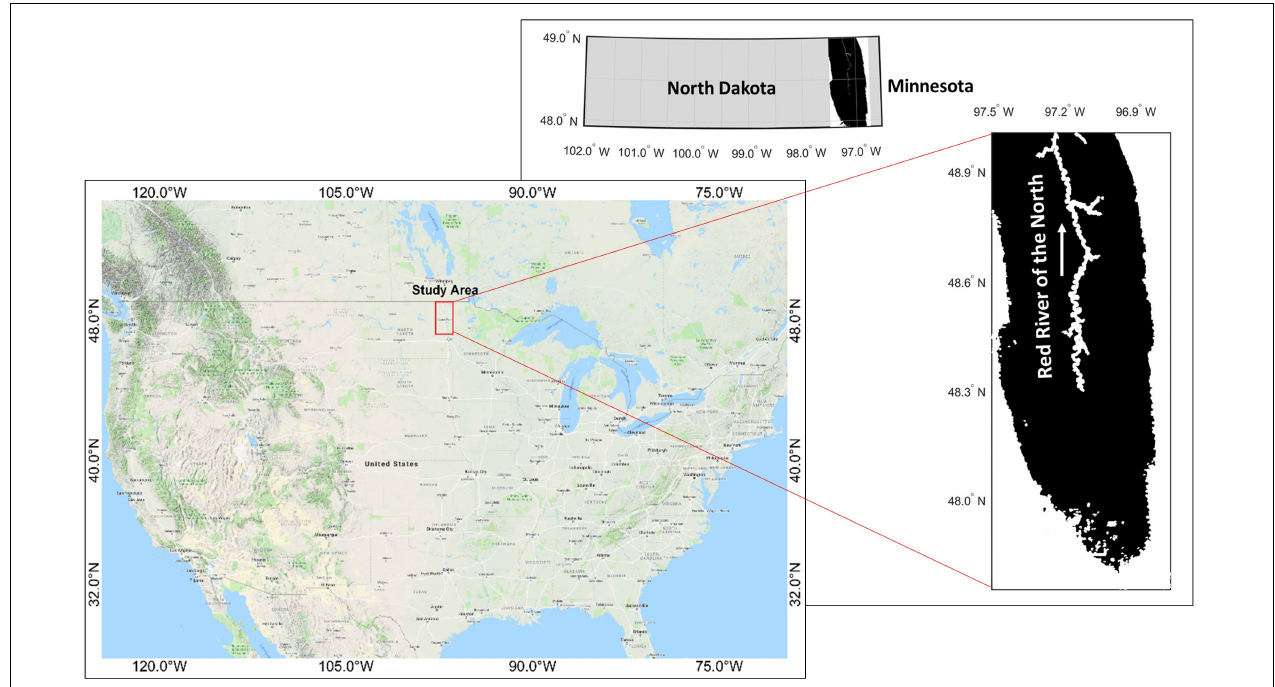
FIGURE 1 | Map of the study area, with the Red River of the North flowing toward the United States-Canada border.